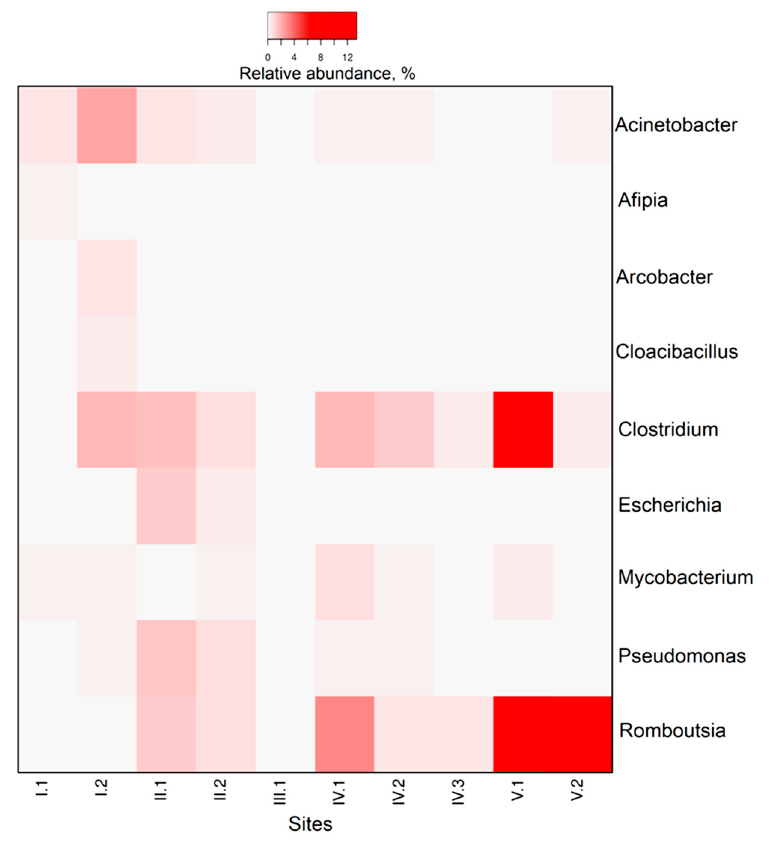
Figure 9. The distribution of potentially pathogenic microbial genera in different zones of the CW. The pathogenicity of Romboutsia has not yet been confirmed, but they were included to the figure as they are typical human gut inhabitants.